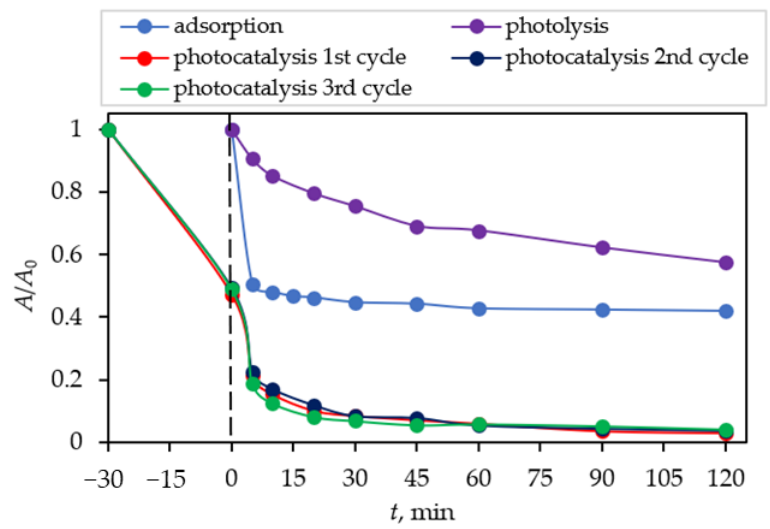
Figure 8. Dark adsorption and photolytic and photocatalytic degradation of CIP as a function of irradiation time by the Fe 3 O 4 /SiO 2 /TiO 2 nanocomposite synthesized at 100 °C.